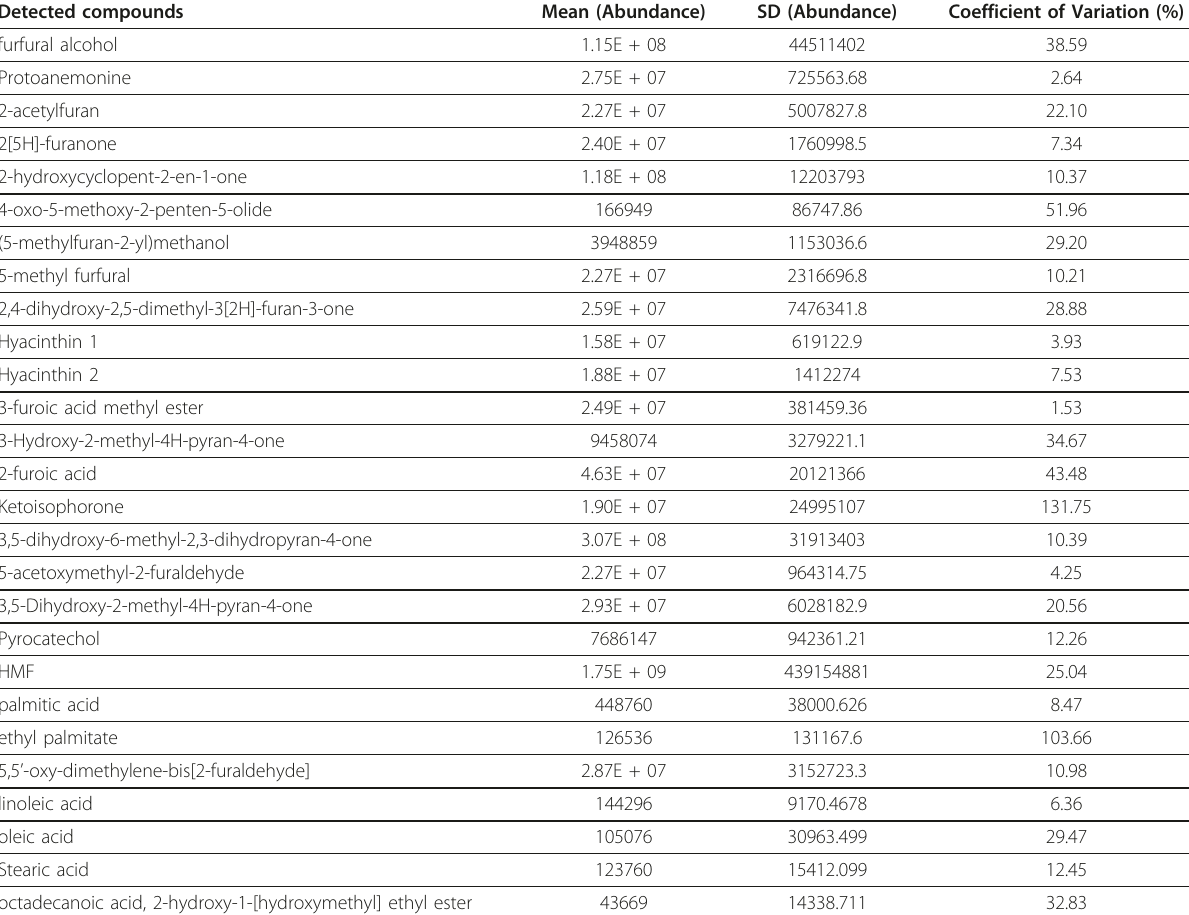
Table 3 Twenty seven compounds detected with methanolic extracted honey Detected